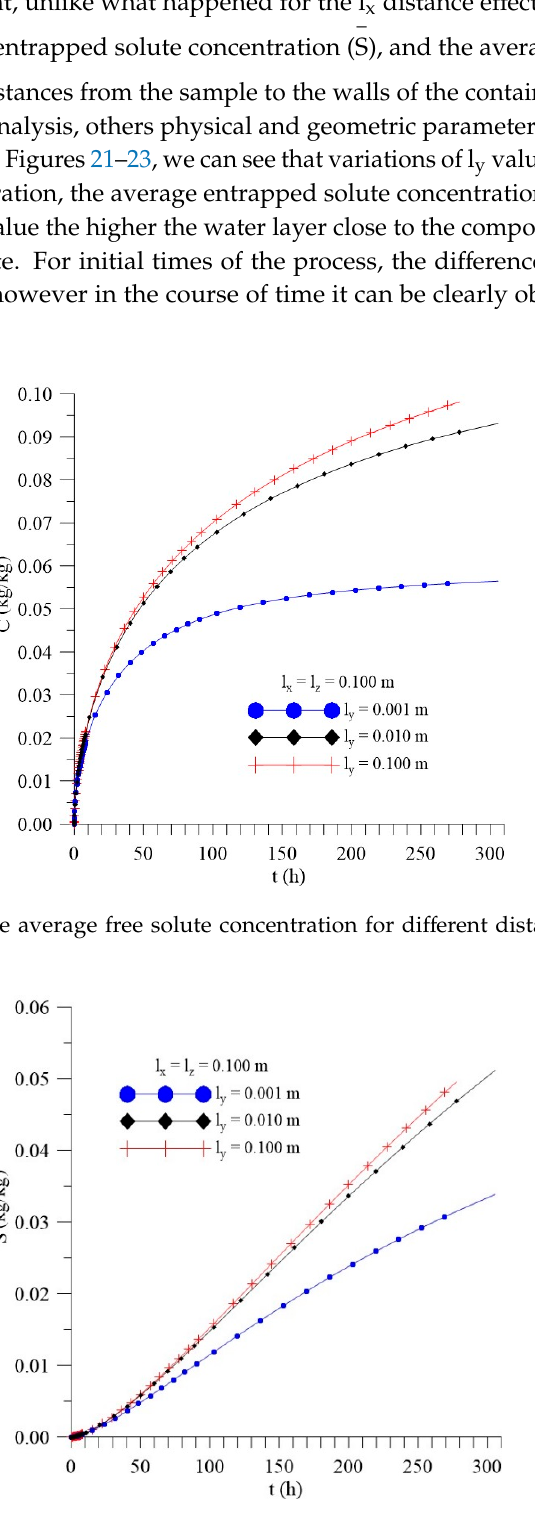
Figure 22. Kinetics of the average entrapped solute concentration for different distances l y (Cases 9, 11, and 12).